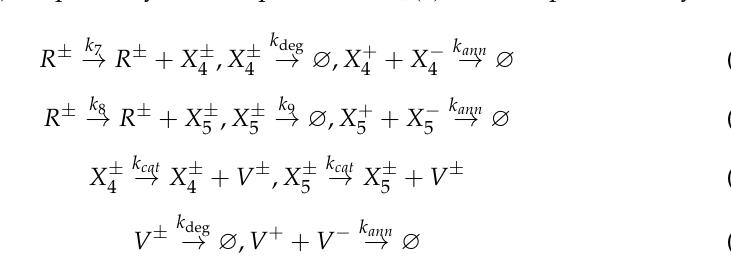
In set-point filter